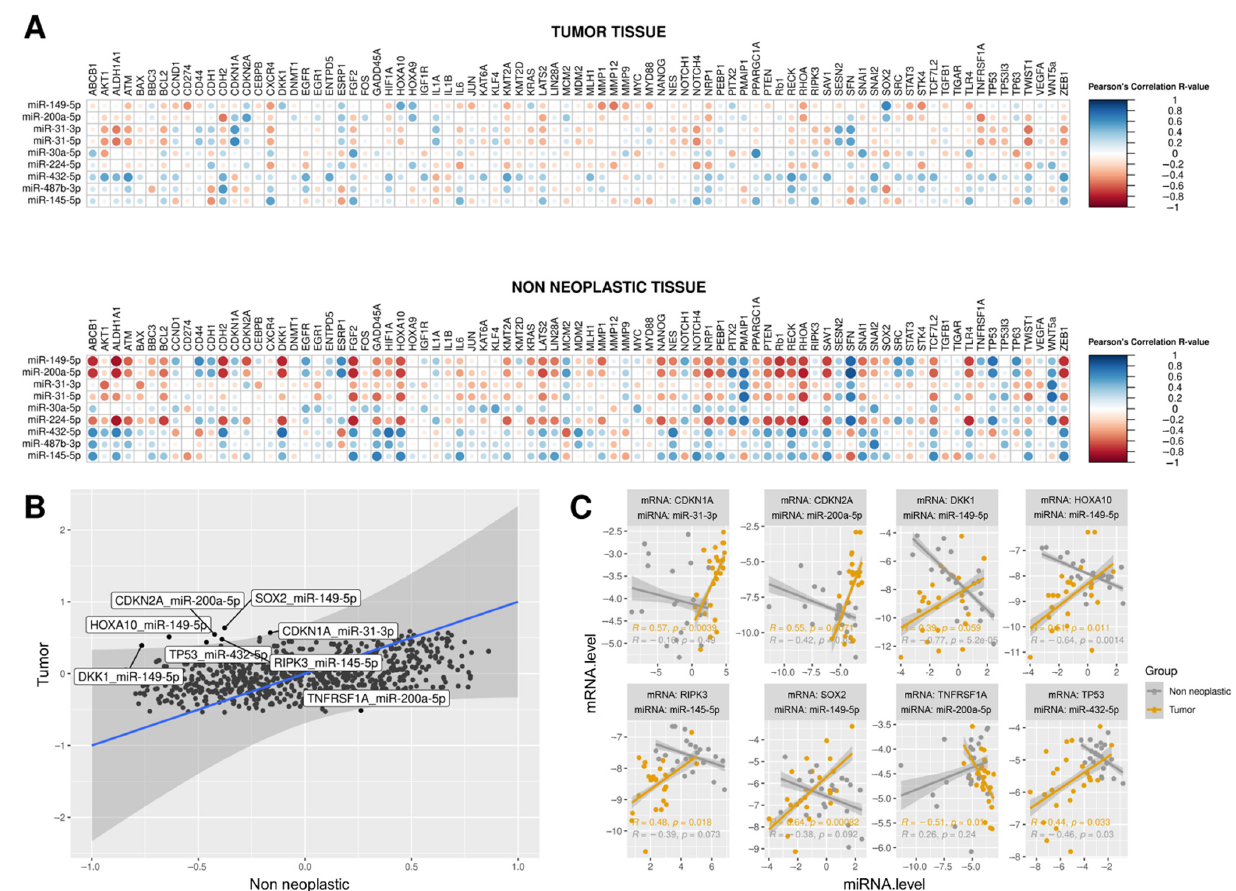
Figure 5. Pair-wise correlations between expression levels of 9 miRNAs and 83 genes in tumor tissues (TT) and non- neoplastic tissues (NNT) considering the total sample of 24 PeC patients. ( A ) Pearson correlation coefficients between expression levels of miRNAs and genes showed different profiles across TT and NNT samples. The size and color of each dot represent the Pearson correlation R-values for each miRNA-mRNA pair; ( B ) R-values were plotted, and eight miRNA-mRNA pairs out of the confidence interval of the linear equation were labeled and selected for further analysis. Each axis represents the correlation R-value for a specific tissue (TT or NNT); ( C ) miRNA and gene expression values (-delta CT) of TT ( n = 24) and NNT ( n = 24) were plotted for the eight miRNA-mRNA pairs selected in ( B ). For each graph, the R coefficient and p values of the Pearson Correlation test are indicated at the bottom.